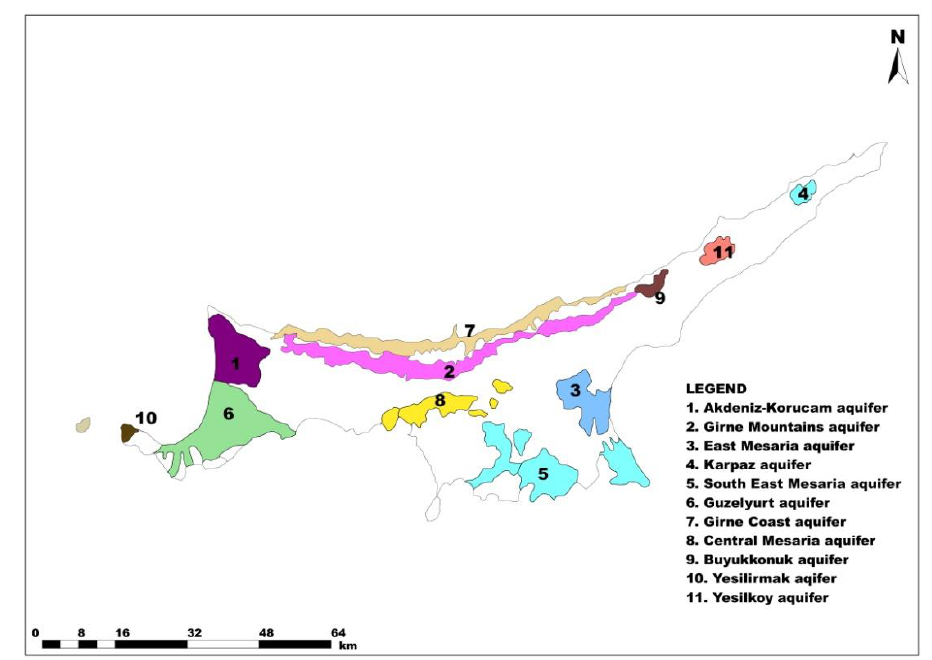
Figure 4. Schematic map of aquifers and their locations in NC (Department of Geology and Mines, 2018).